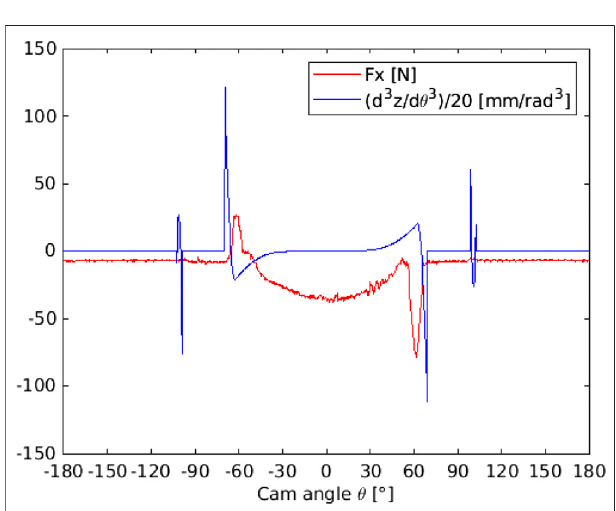
FIGURE 14 | Friction force (F